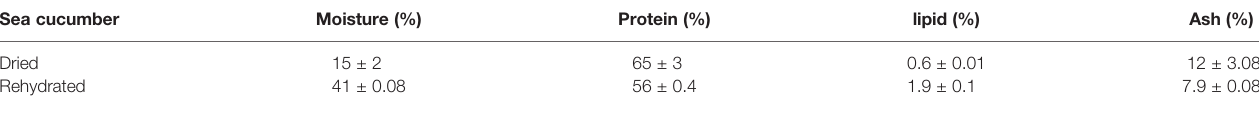
TABLE 2 | Chemical composition of processed dried and rehydrated sea cucumber ( Holothuria scabra ). Sea cucumber Moisture (%) Dried